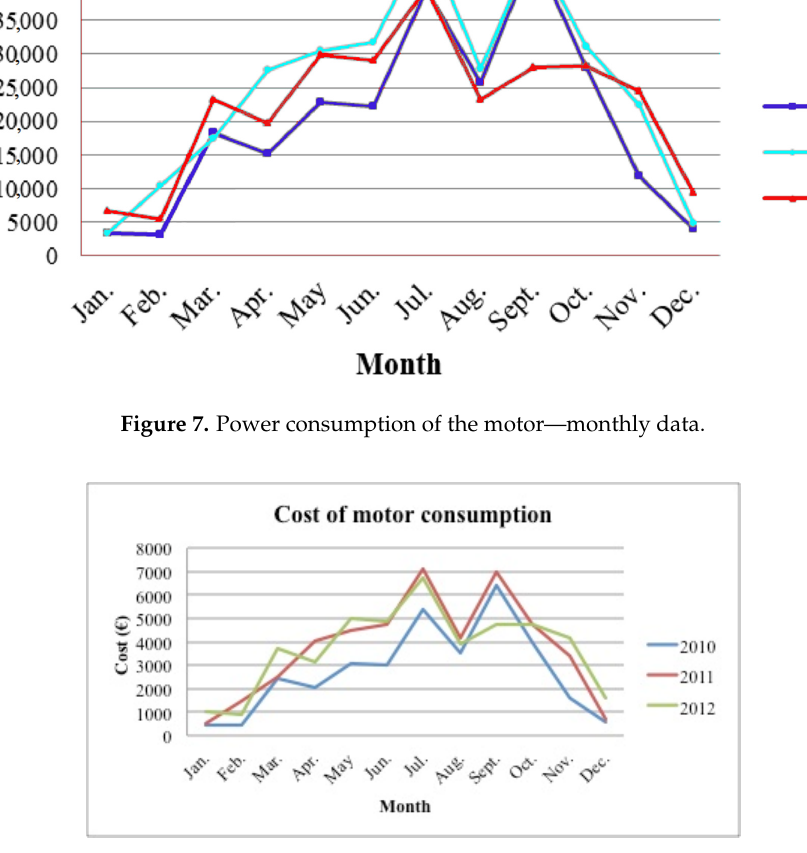
Figure 8. Costs of motor power consumption—monthly data.